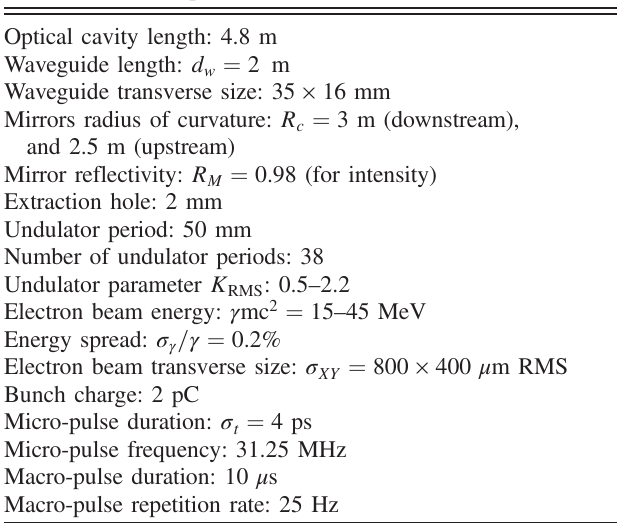
TABLE II. Main parameters used for CLIO.